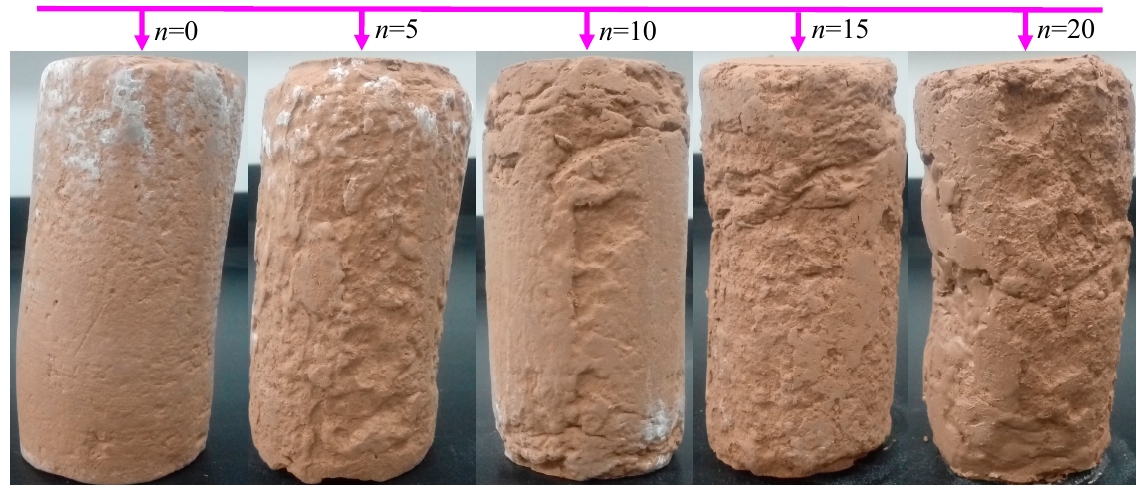
Figure 12. Specimen after creep